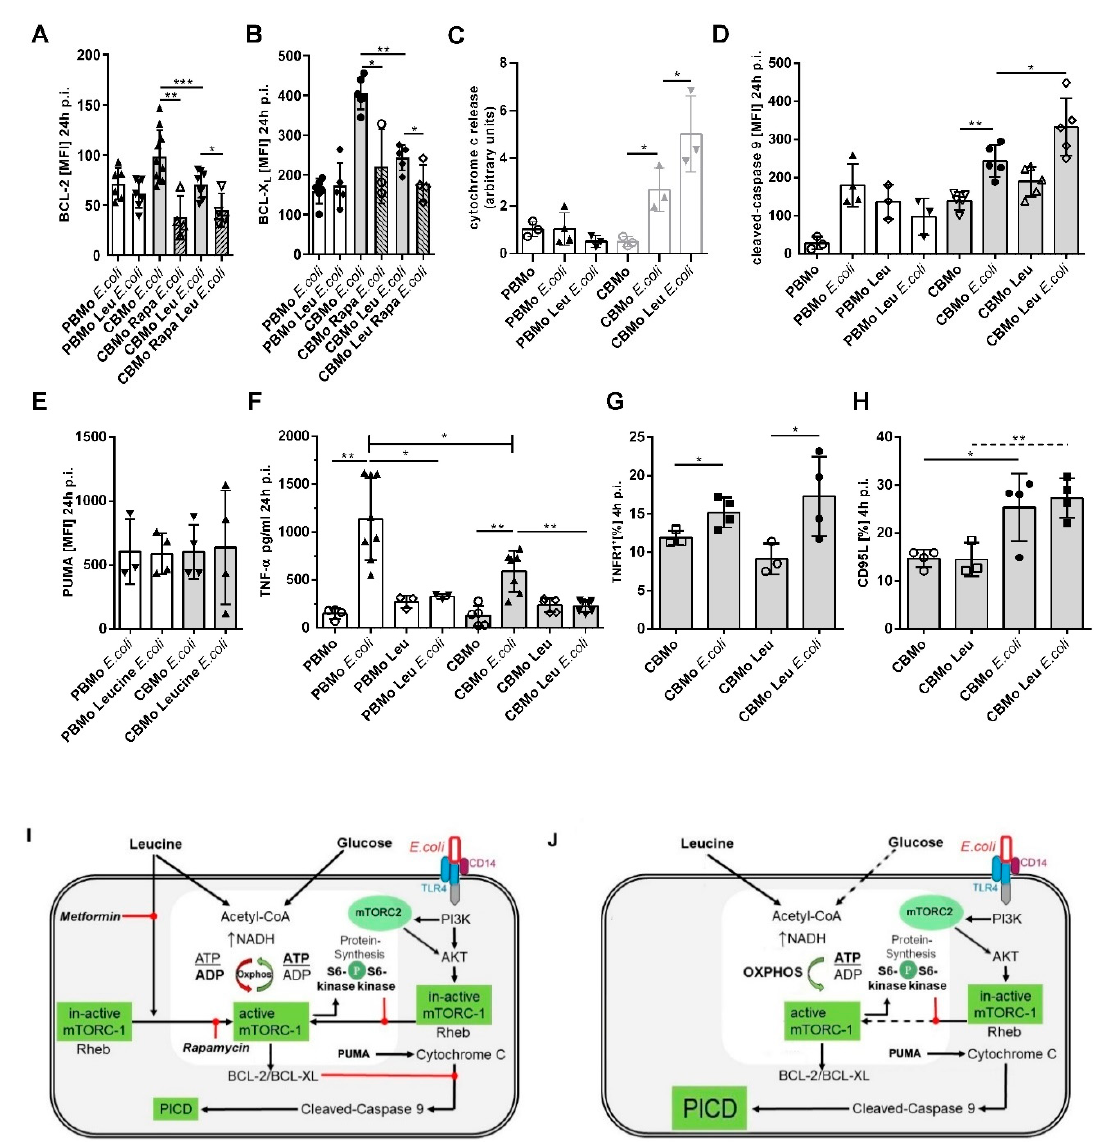
Figure 5. Leucine-dependent PICD activates components of the intrinsic apoptotic pathway. The median expression of BCL-2 ( A ) and BCL-XL ( B ) was assessed under indicated conditions. Rapamycin (Rapa) was added together with leucine (Leu). Cytochrome C release was detected via immunoblot analysis. Cytosolic cytochrome c was quantified from the independent number of immunoblots indicated ( C ). Caspase-9 cleavage ( D ) and the pro-apoptotic factor PUMA ( E ) was compared between PBMo and CBMo for the infection interval indicated (Student’s t -test * p < 0.05; ** p < 0.01; *** p < 0.005, ANOVA test in F , * p < 0.05). ( G ) CBMo expressing TNFR1 and CD95L ( H ) were assessed via FACS staining (Student’s t